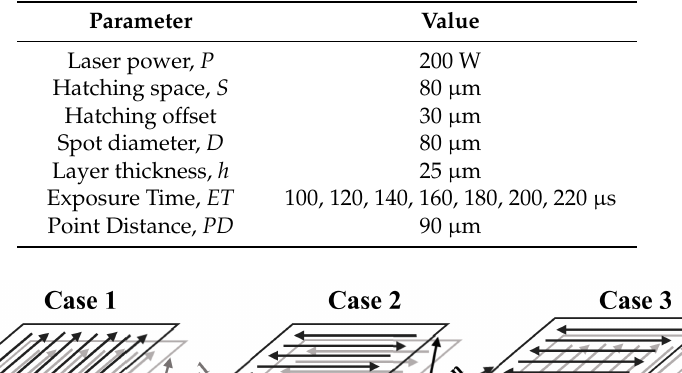
Table 1. The process parameters used in the laser powder bed fusion (LPBF) process.